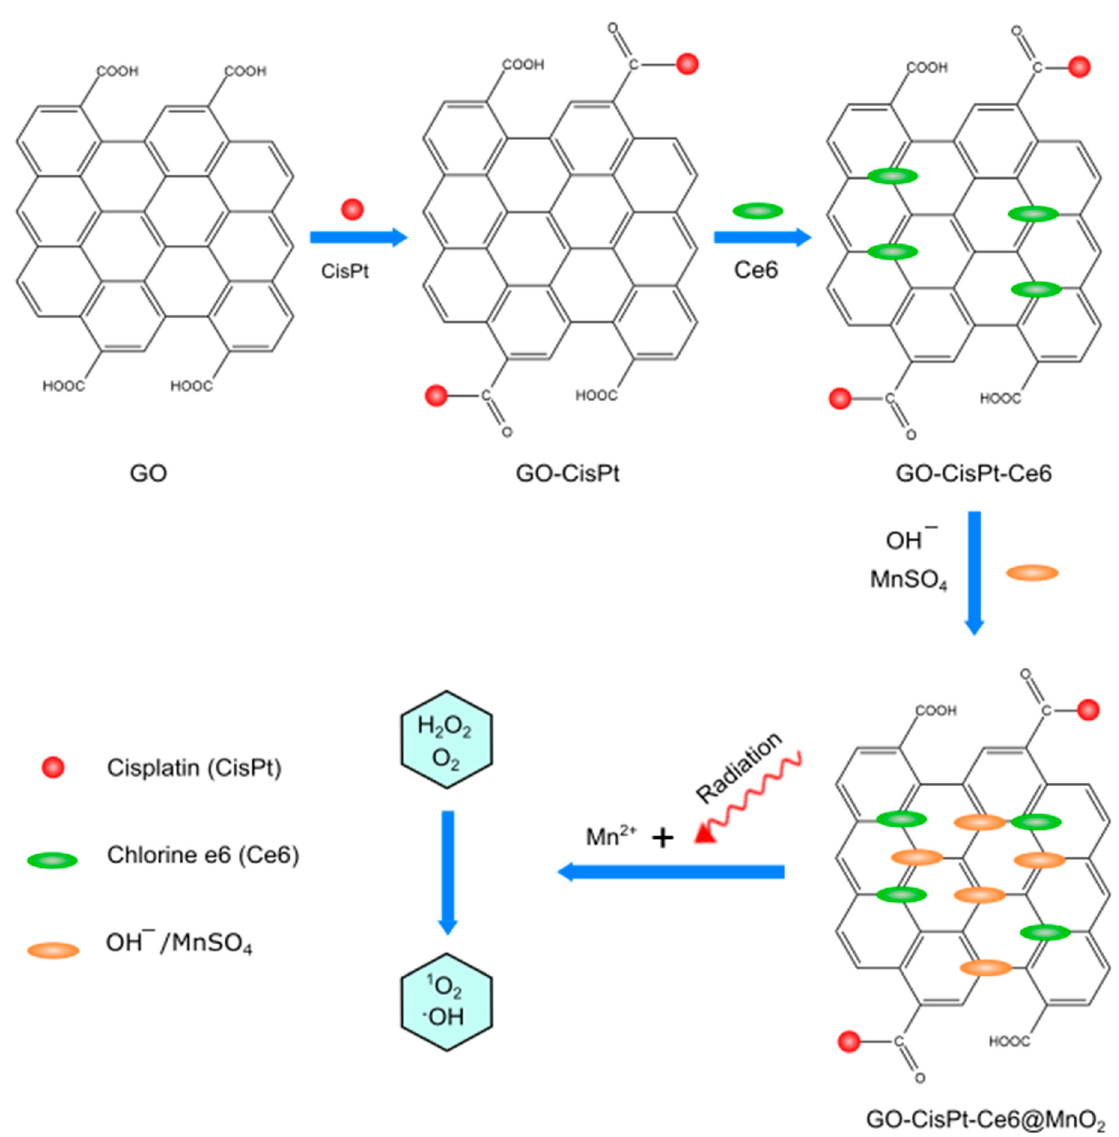
Figure 8. Preparation routes of Go-CisPt-Ce6@MnO 2 . Graphene oxide: GO (figure created with Inkscape).